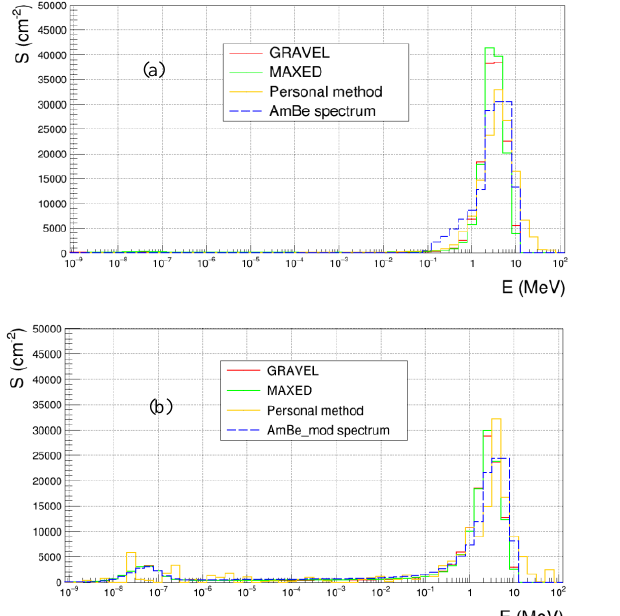
Fig. 8. Unfolding results (cm -2 ), as function of energy (MeV), with a moderated 252 Cf guess spectrum and high statistics (Φ = 1.41×10 5 cm -2 ). (a), an unmoderated Am/Be source. (b), a moderated Am/Be source